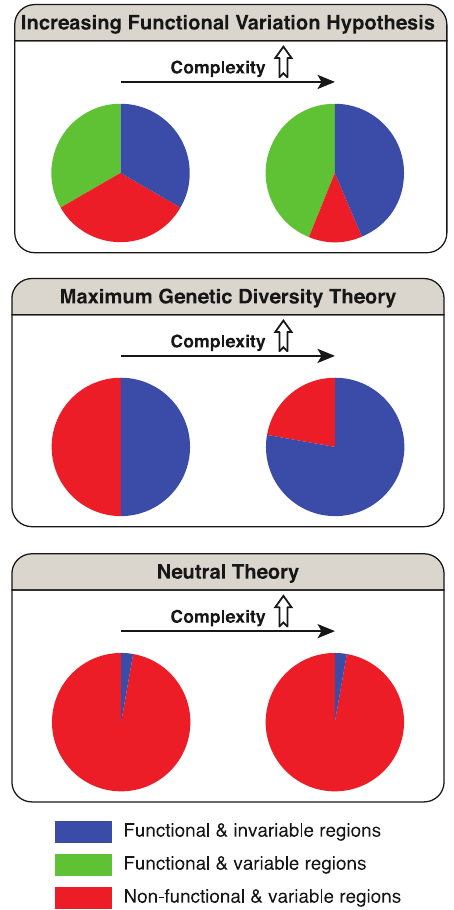
Figure 1. Comparison of IFV, MGD, and neutral theory. While the neutral theory and MGD theory analyze genome structure as bipartite, the IFV hypothesis adds an additional region which is the variable and functional gene regulatory region. As species complexity increases, the variable region of the genome would stay as variable according to neutral theory. While in MGD theory, as species complexity increases there would be less variable region. Unlike MGD theory, IFV hypothesis states that the functional variable region which contains gene regulatory elements would also increase with species complexity.